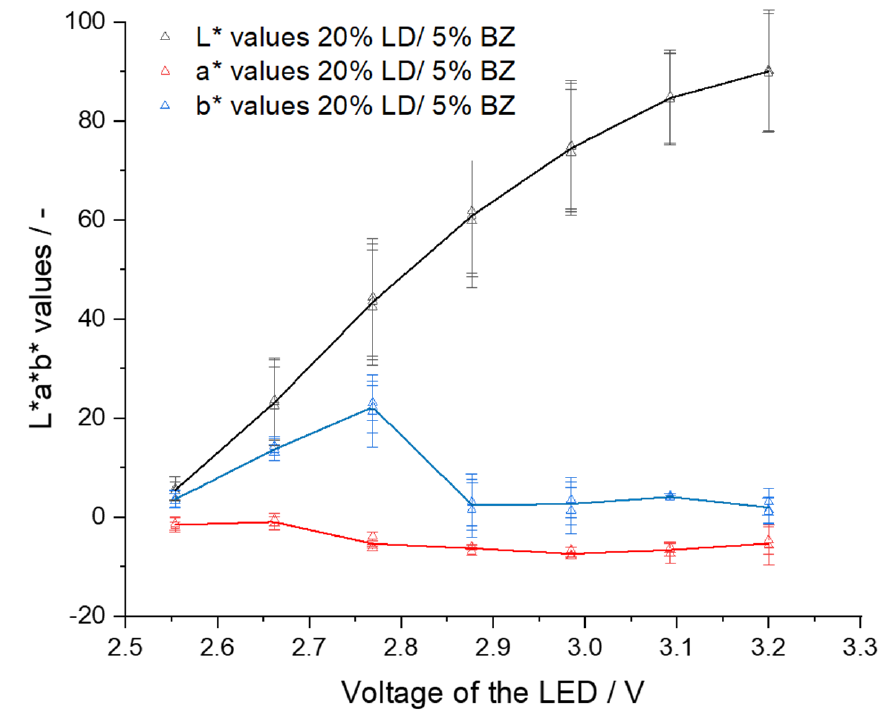
Figure 5. L*a*b* values depending on LED voltage for EC- 20% LD/ 5% BZ filaments (mean ± SD, three filaments, n = 6).